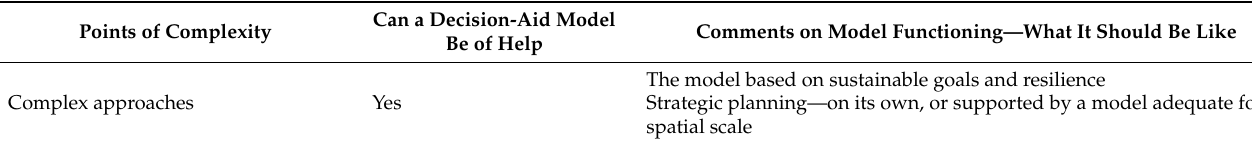
Table 3. Complexities 3, opportunities and requirements of a decision-aid model, related to complexi- ties in considering the spatial